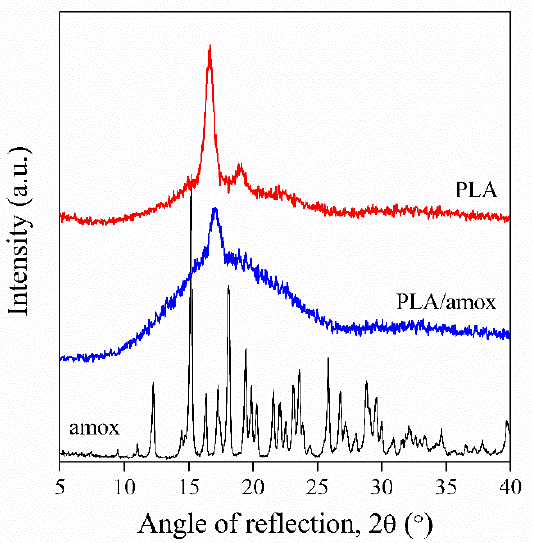
Figure 3. XRD patterns of Amox powder, PLA, and PLA containing 1.23% Amox.